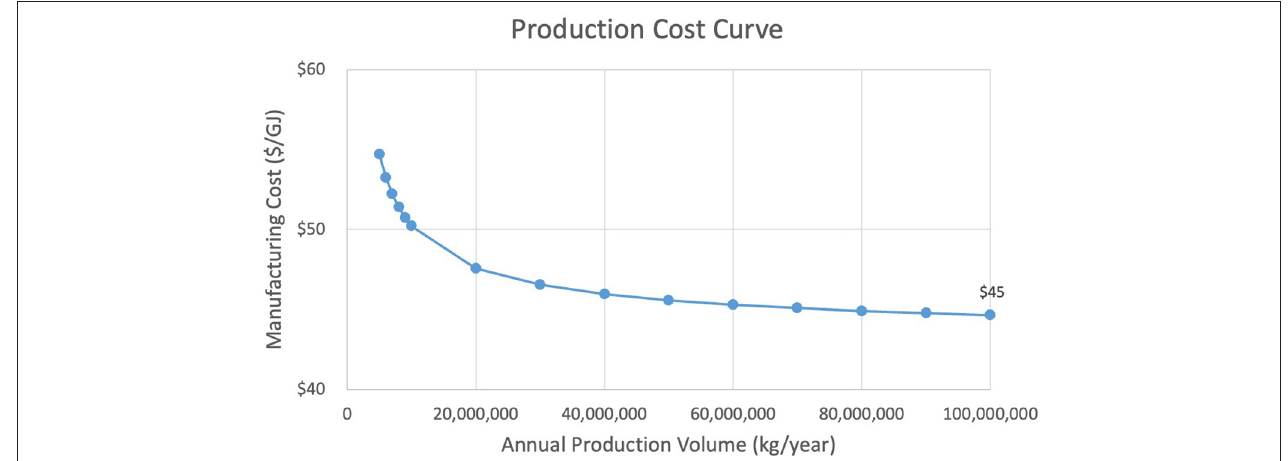
FIGURE 5 | Manufacturing cost per gigajoule of output decreases as annual production volume